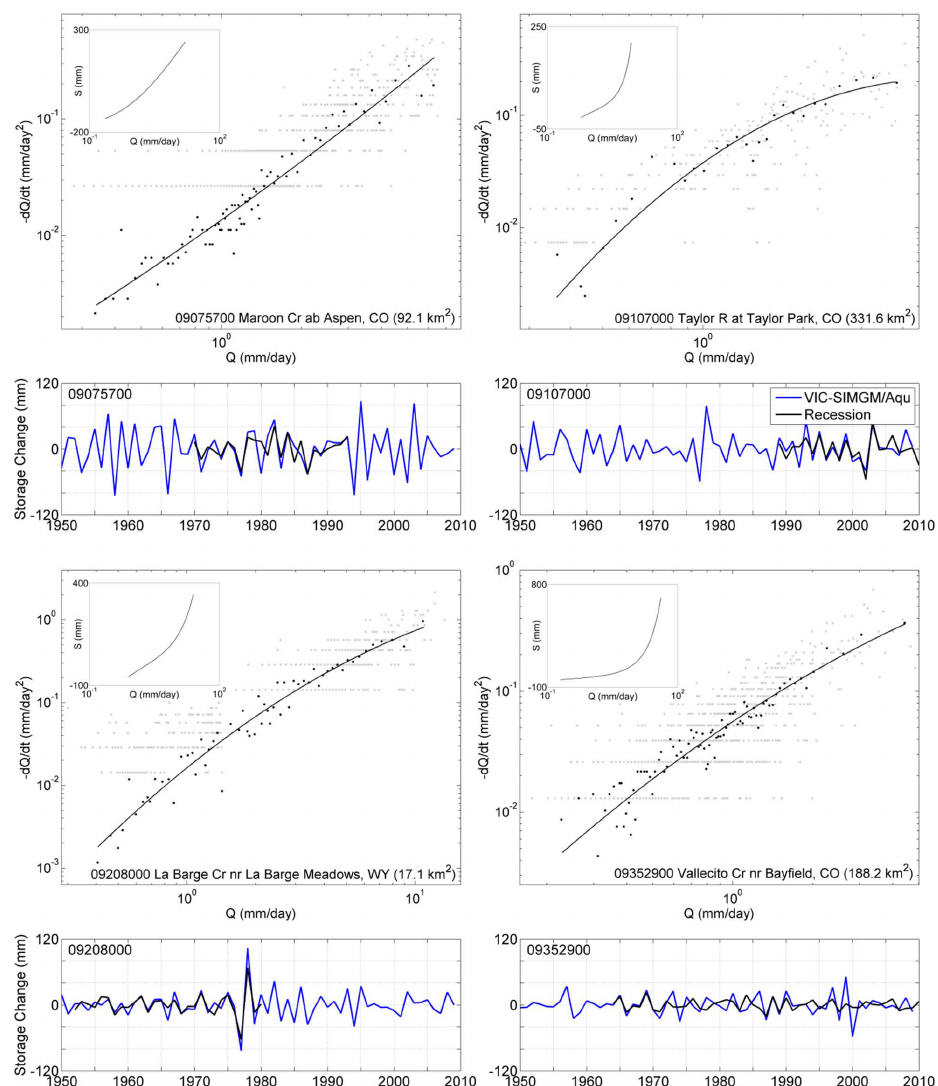
Fig. 8. Recession plots and associated storage functions (insets) for four reference watersheds. Annual changes in groundwater storage as derived from storage functions are compared with those derived from VIC-SIMGM below their respective recession plots. Watersheds are located in sub-basin 2 (09075700), sub-basin 3 (09107000), sub-basin 9 (09208000), and sub-basin 18 (09352900), with drainage areas provided in